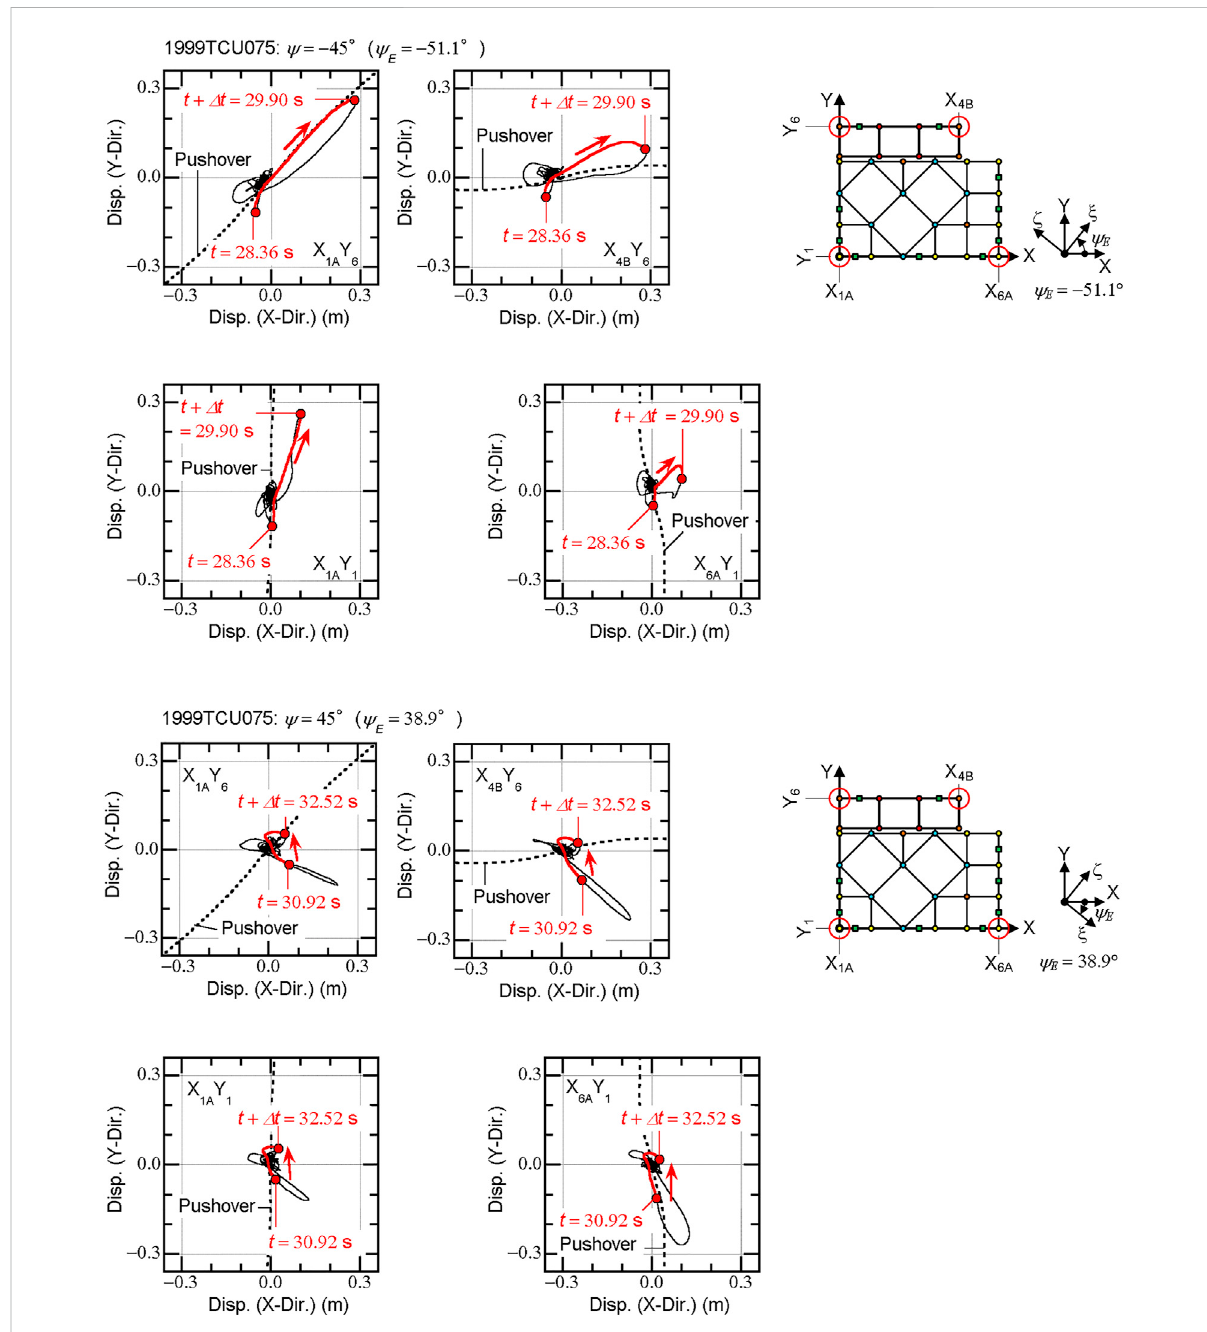
FIGURE 13 Displacement orbit of the four isolates at the